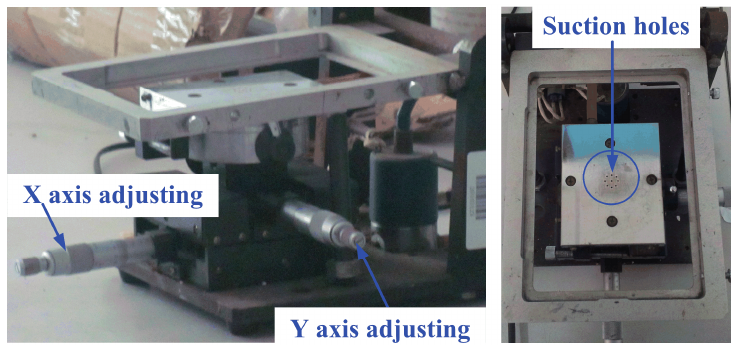
Figure 5. Manual screen-printing platform.